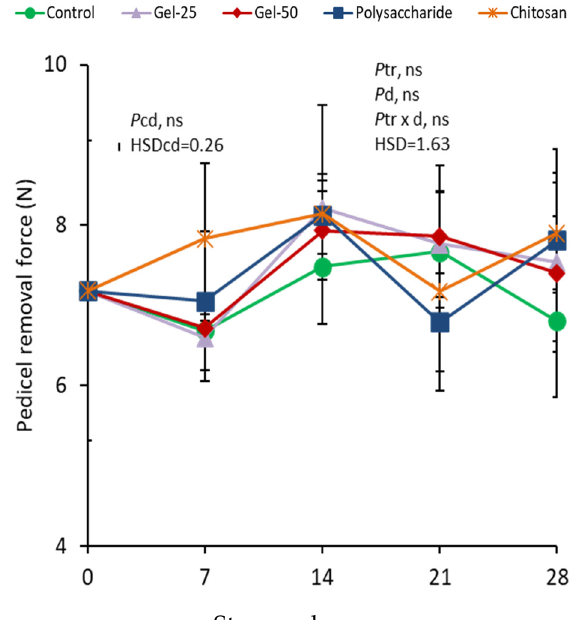
Figure 4. Effect of edible coatings on changes in pedicel removal force in cherries during storage. Points are means of three replicates of 10 cherries each; bars on the points, ± standard deviations. NS, non significant. Pcd , probability of storage days in controls (one-way ANOVA from day 0); HSDcd, honest significant difference calculated from ANOVA. Ptr , probability of edible coating treatment; Pd , probability of storage days; Ptr × d , probability of interaction (two-way ANOVA from day 7); HSD, honest significant difference calculated from ANOVA.